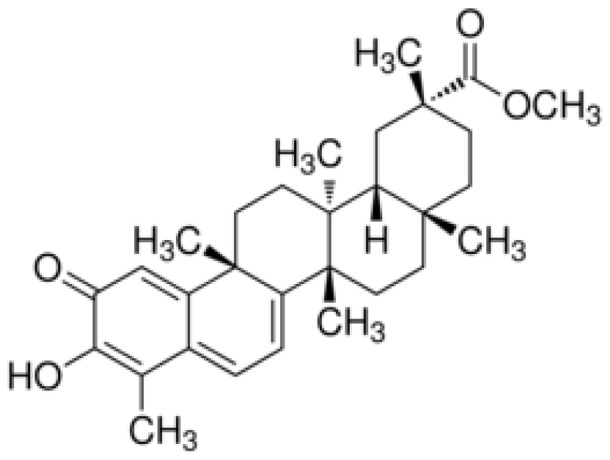
Chemical structure of pristimerin.